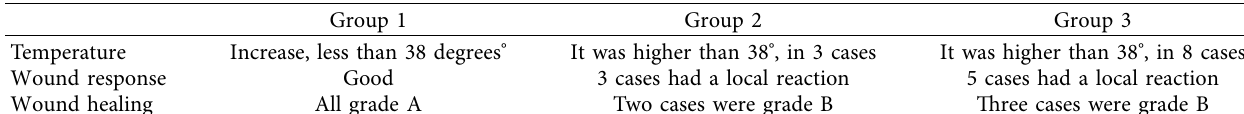
Table 1: Observation of clinical signs.